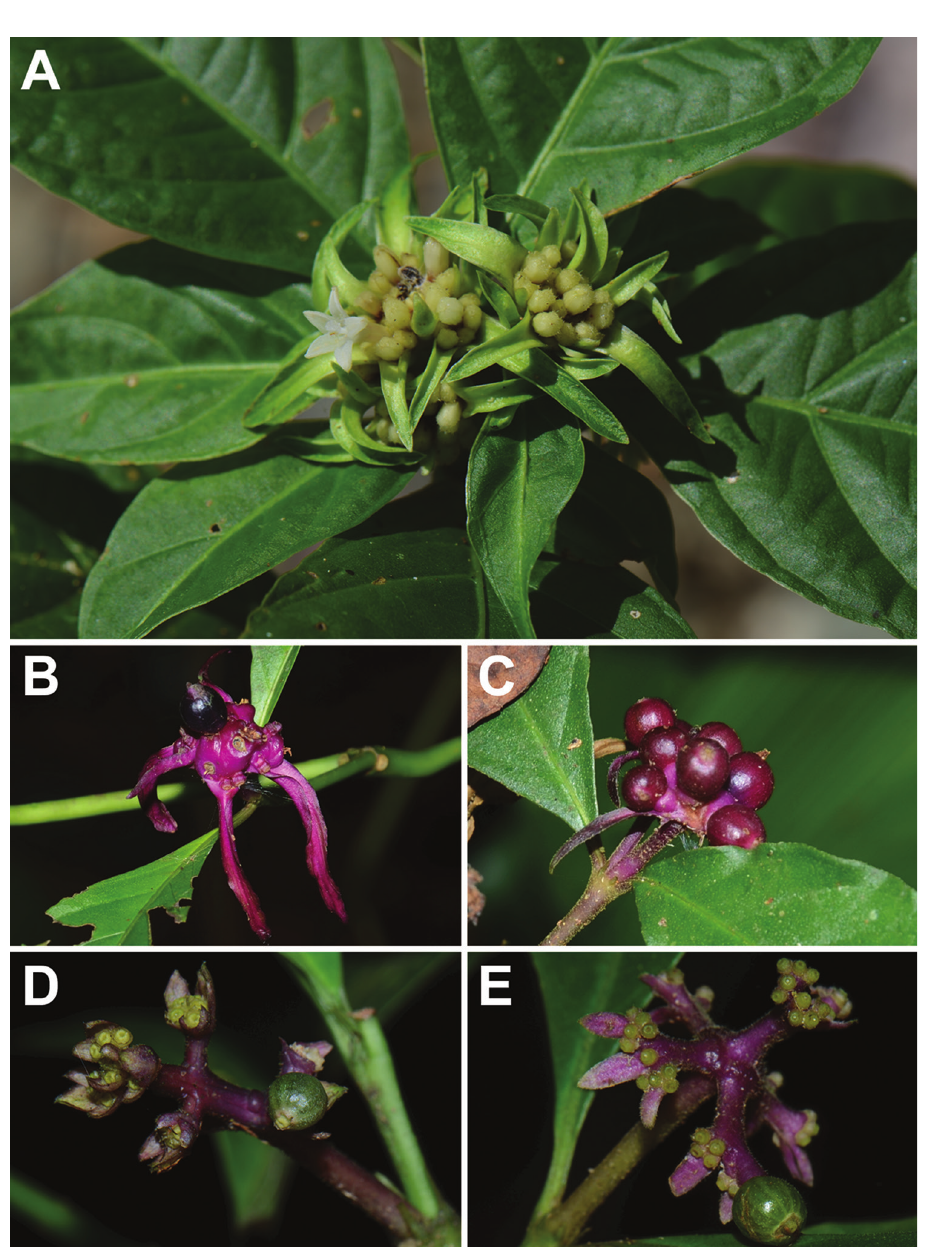
Figure 1. Palicourea longiinvolucrata and related species, note diagnostic differences in bract arrange- ment and length. Palicourea longiinvolucrata , inflorescence ( A Berger 1418 ) and infructescence ( B Berger 1633 ); Palicourea hoffmannseggiana , infructescence ( C unvouchered); Palicourea gracilenta , infructescence ( D Berger 2055 ); Palicourea winkleri , infructescence ( E Berger 1737 ). All photos by the